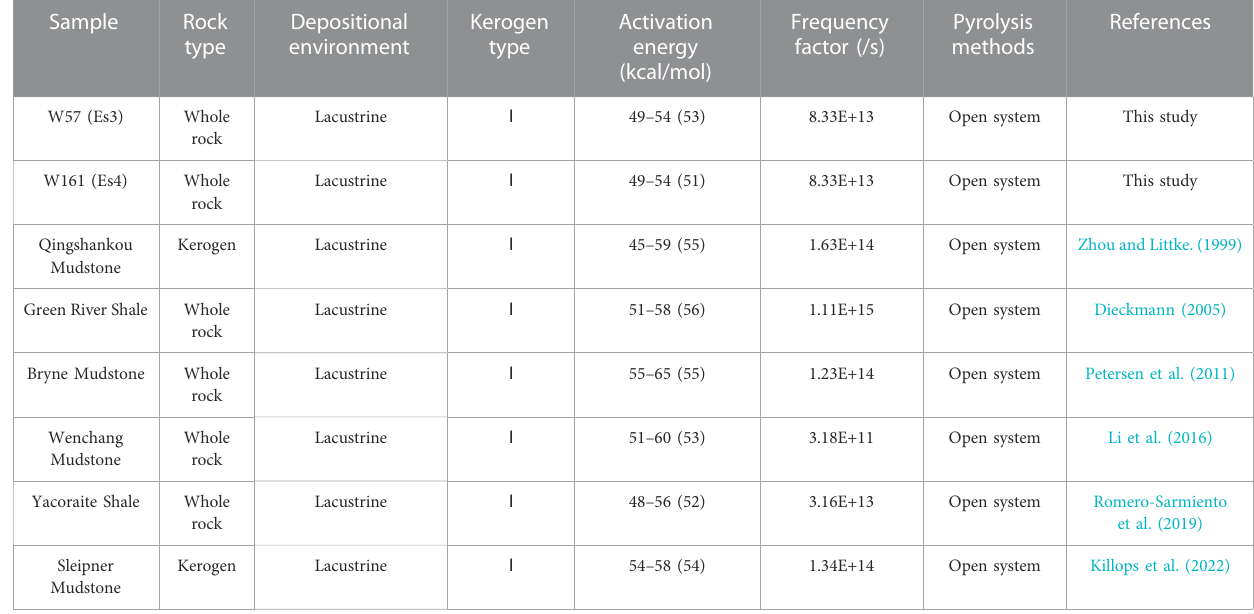
TABLE 4 Summary of some published kinetic experiments on lacustrine source rocks containing type I kerogen.